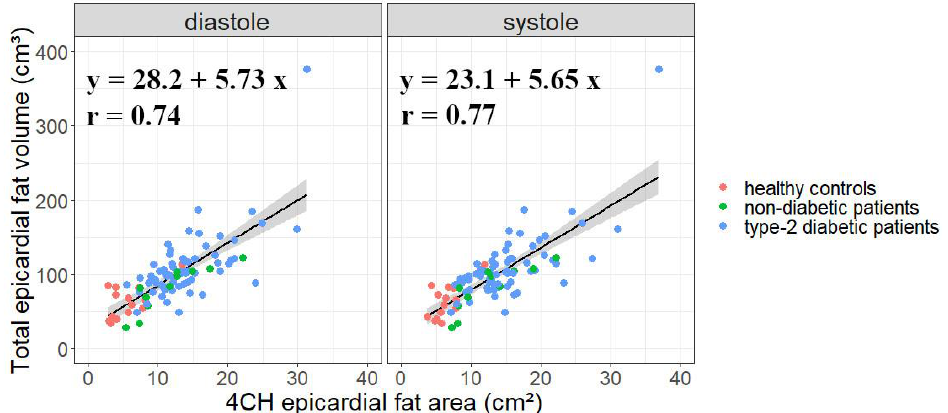
Figure 3. Comparison of reference total epicardial fat volume andproposed EAT area measured on four-chamber cine. EAT area was measured in end-systolic or end-diastolic frame across the 100 subjects’ database. The three cohorts merged for the database were identified by markers color.